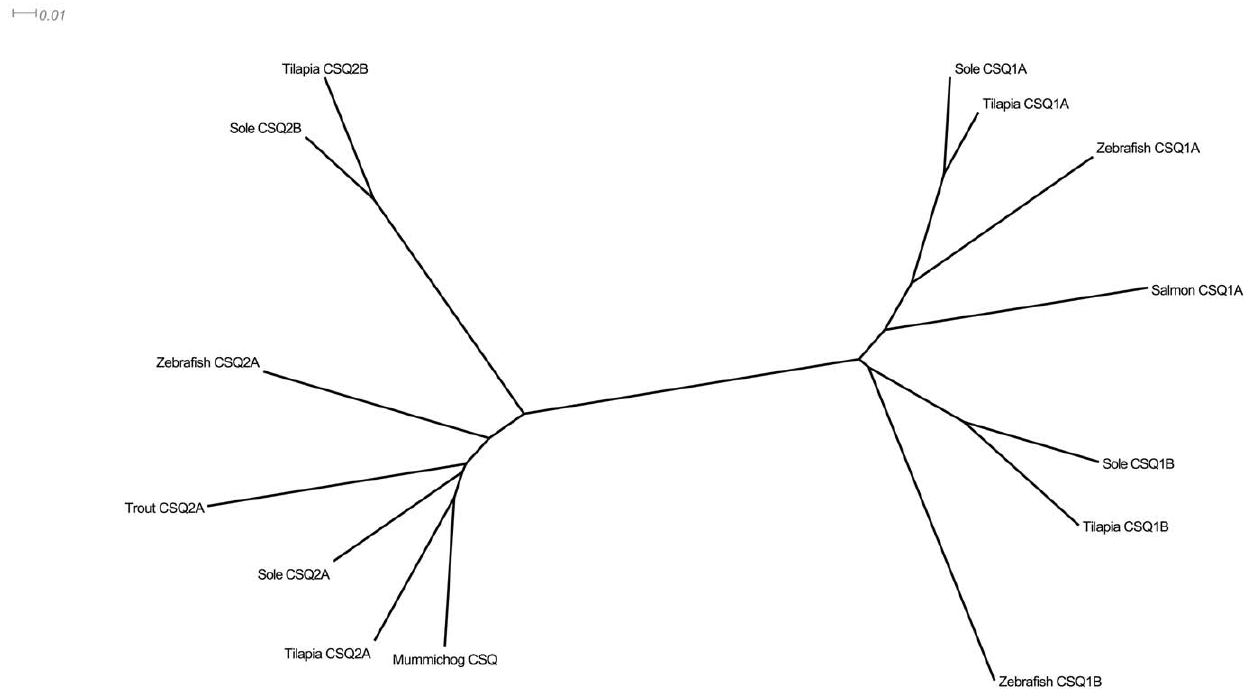
Figure 2. Neighbor-joining tree displaying relationships between CSQ orthologs and paralogs. Teleost fishes express multiple isoforms of CSQ in a variety of tissues. FCSQ (mummichog CSQ) aligns most closely with CSQ2A isoforms.